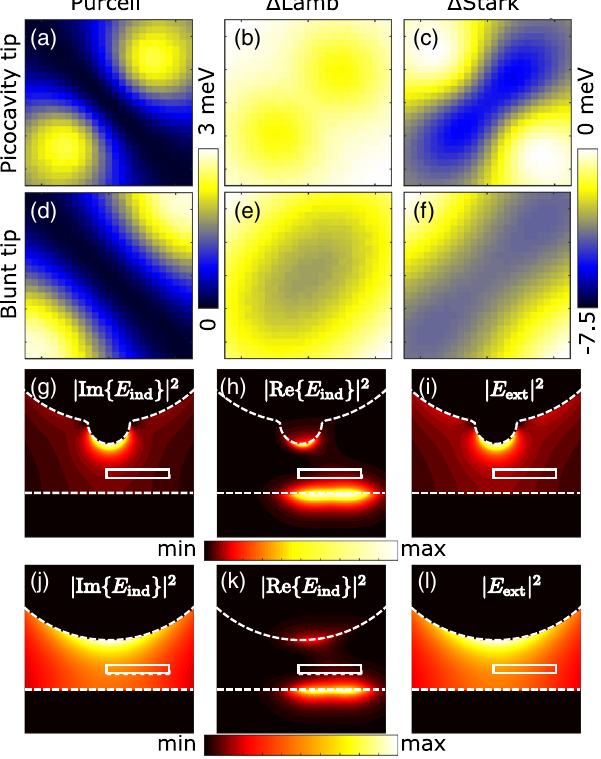
FIG. 4. Dissecting the line broadening and line shift of a single- molecule exciton in a STM plasmonic cavity. We show the theoretical maps of (a,d) the linewidth, and the variation of (b,e) the Lamb shift and (c,f) the Stark shift induced in (a) – (c) the plasmonic picocavity and (d) – (f) the cavity formed between the blunt tip and the substrate. The values of the shifts are displayed in relative units with respect to the maximal value obtained in the maps. The size of the mapped area is 2 . 5 × 2 . 5 nm 2 . The color scales in panels (a,d) and panels (b,c,e,f), respectively, are 2 and (h,k) j Re f E 2 with E identical. (g,j) j Im f E ind gj ind gj ind ¼ − ∇ ϕ . The induced fields are generated by the Q exciton of a x ind molecule whose position is marked by the white dashed rec- 2 ¼ j ∇ ϕ 2 . Calculations in tangle. Panels (i,l) show j E exc j ext j panels (g,h,i) and (j,k,l) have been done for the picocavity tip and the blunt tip, respectively. All the fields are displayed in the plane y ¼ 0 intersecting the tip axis. The size of the displayed region is 4 × 4 nm 2